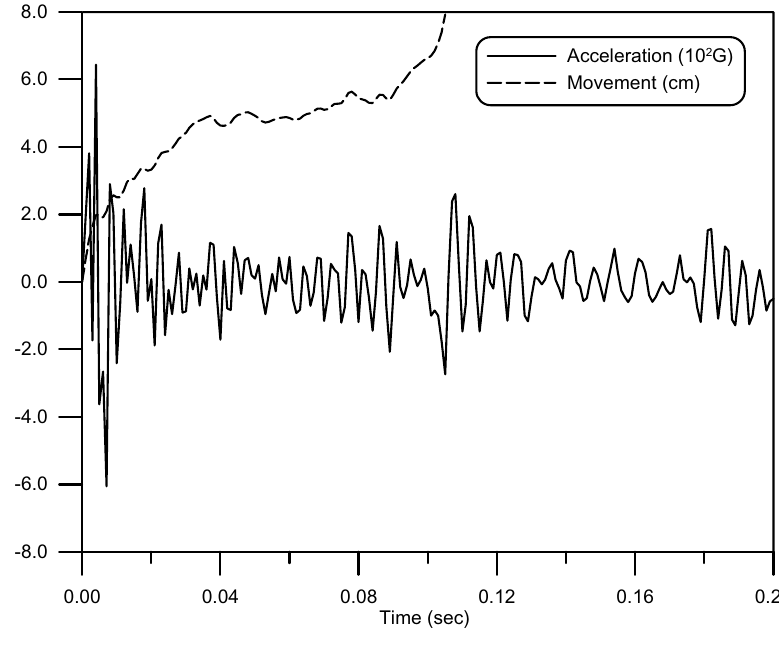
Fig. 8. Acceleration and movement at the standoff point.